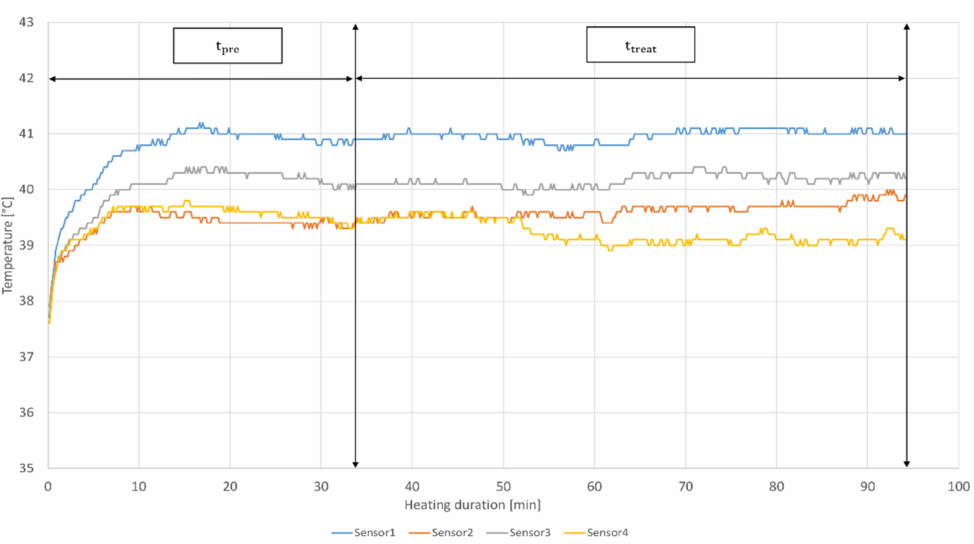
Figure 1. Recorded treatment data of a single HT session for a breast cancer patient. Temperature in ◦ C and heating duration in minutes are measured non-invasively using four sensors located in close proximity to the tumor tissue. t pre and t treat of 33 and 60 min respectively according to the KSA clinical protocol are